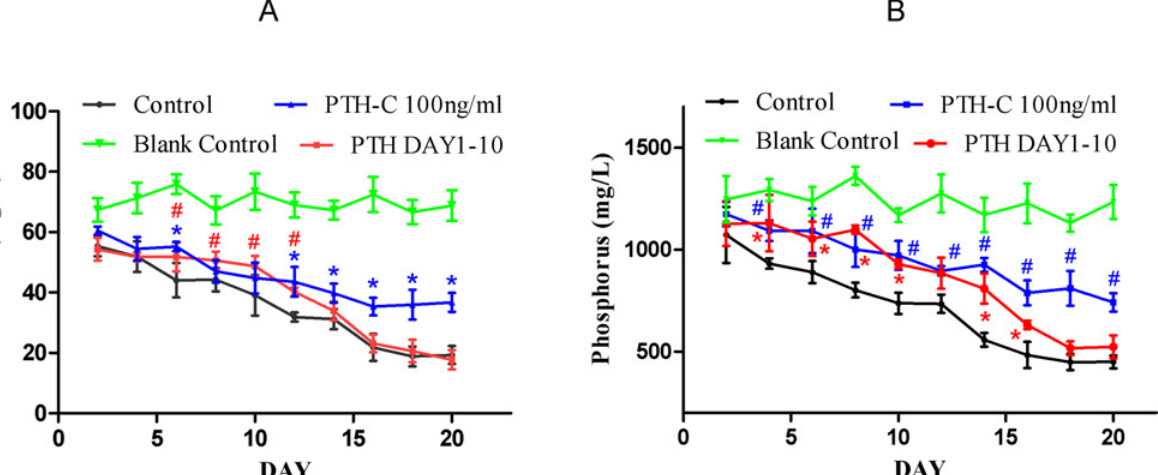
Fig 5. Effects of PTH withdrawal on calcium and phosphorus in culture. Calcium and phosphorus derived from control and bPTH treated cultures at different time points. In the control group, there was a gradual decline of calcium and phosphorus content that reached a plateau after day 16. Similarly, calcium and phosphorus content slowly decreased with time in continuous bPTH cultures. Although the initial calcium and phosphorus content in cultures treated with transient bPTH decreased more slowly than in controls, they showed a rapid decline after bPTH withdrawal on day 10 and attained similar levels as control. * , # Significantly different compared with control at the same time point, P <